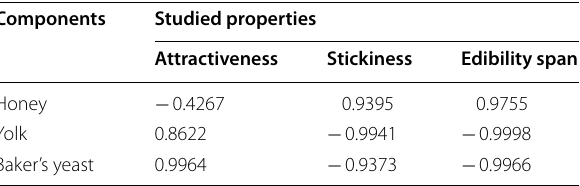
Table 2 Correlation coefficient between the component percentages, in the edible mixtures, and the studied property